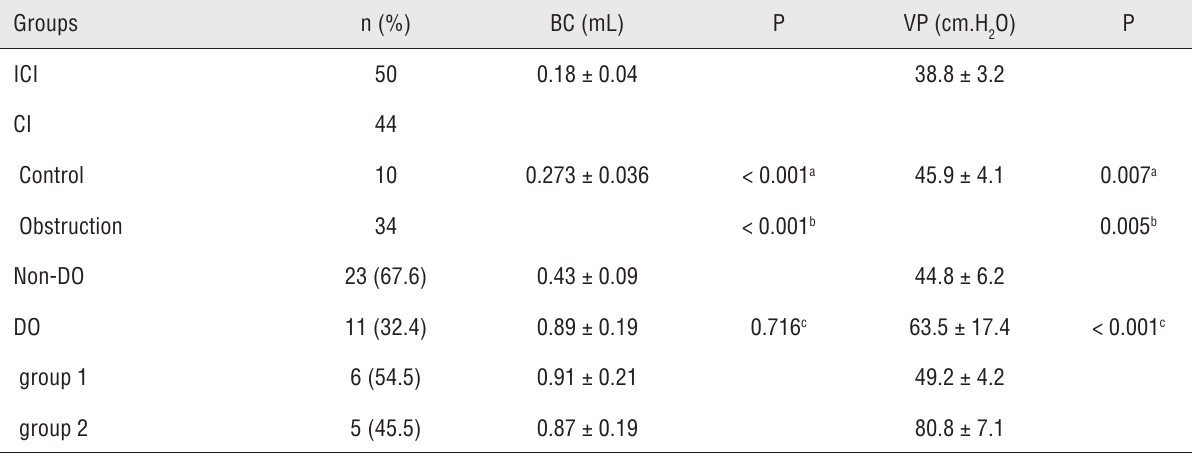
Table 1 - Comparison of cystometric investigation in the control and obstruction rats (Mean ± SD). Groups n